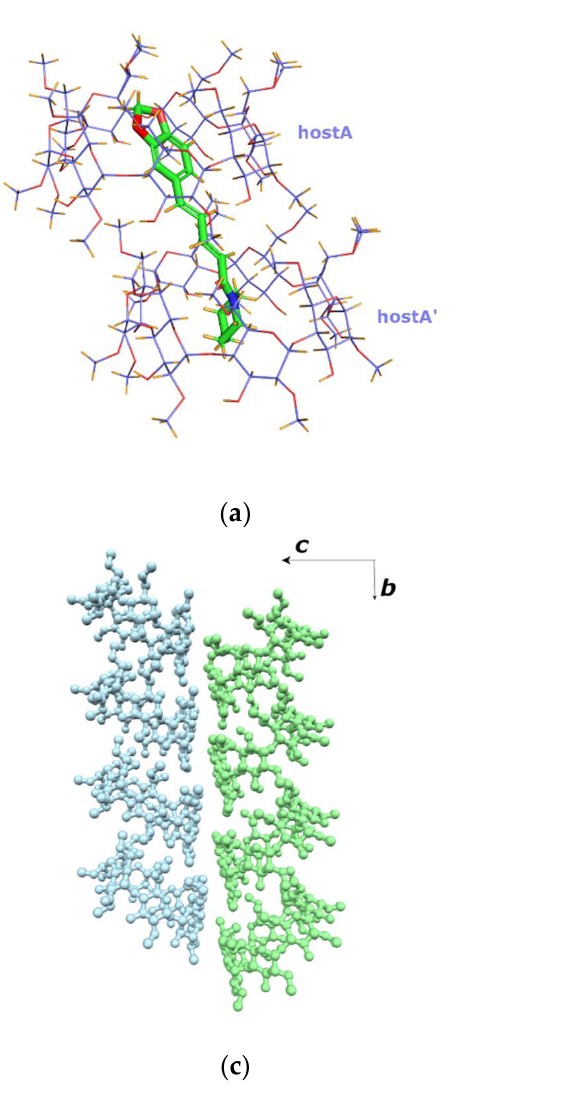
Figure 4. ( a ) A piperine molecule is encapsulated in the hydrophobic moiety formed by two sym- metry related DM- β- CD hosts. ( b , c ) The complex units form columns along the b -axis which are stacked parallel.